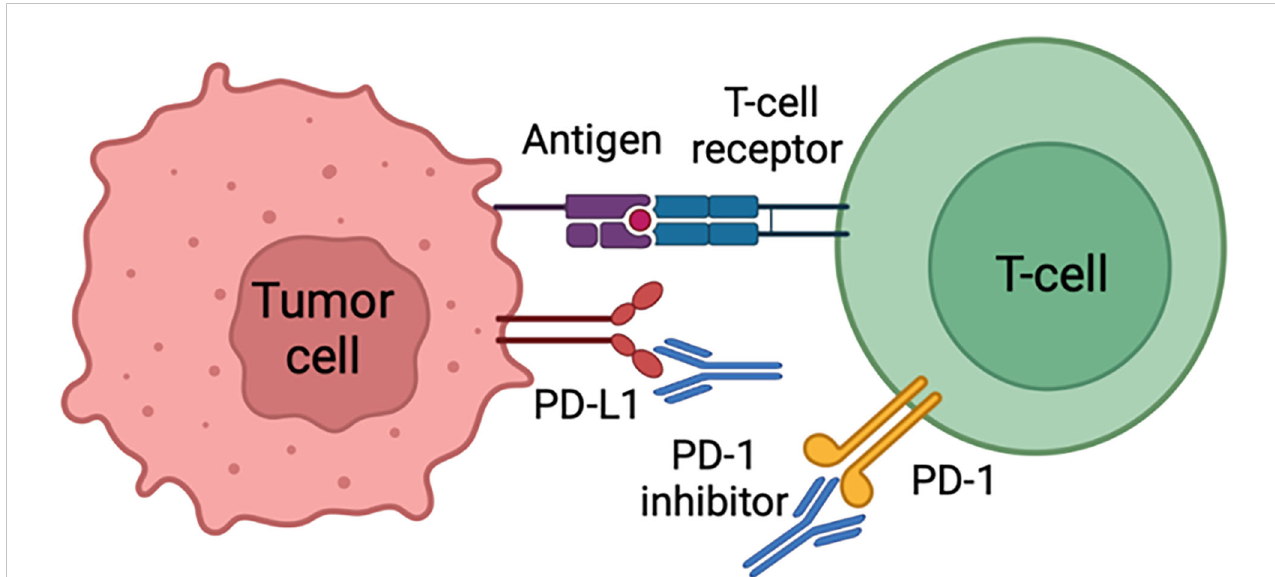
FIGURE 1 Cancer cells can evade immune surveillance by expressing PD-L1 protein that acts as a “ stop sign ” to inactivate T cells. PD-L1 attaches to PD-1 and B7.1 T cell receptors, both of which inactivate T cells. Cemiplimab prevents T cell inactivation and subsequently increases anti-cancer activity through PD-L1